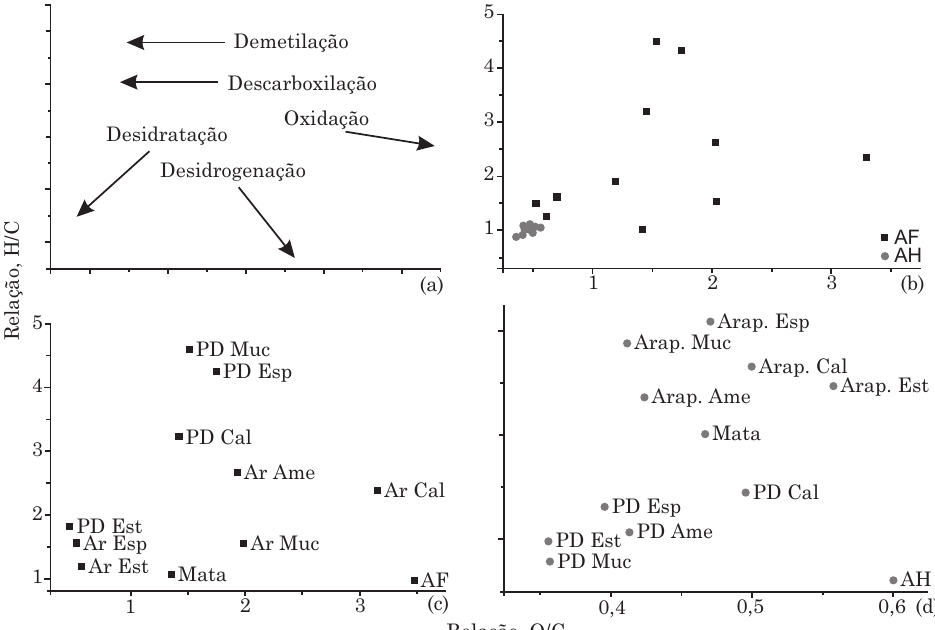
Figura 1. Diagrama de van Krevelen nos ácidos fúlvicos (AFs) e ácidos húmicos (AHs) de solos sob cafezal em Araponga (Ar), Pedra Dourada (PD) e solo sob mata: (a) Principais reações envolvidas nos processos de humificação (adaptado de Rice & MacCarthy, 1991); (b) Diagrama com ácidos fúlvicos (AFs) e ácidos húmicos (AHs) juntos; (c) Diagrama ácidos fúlvicos (AFs); e (d) Diagrama ácidos húmicos (AHs).